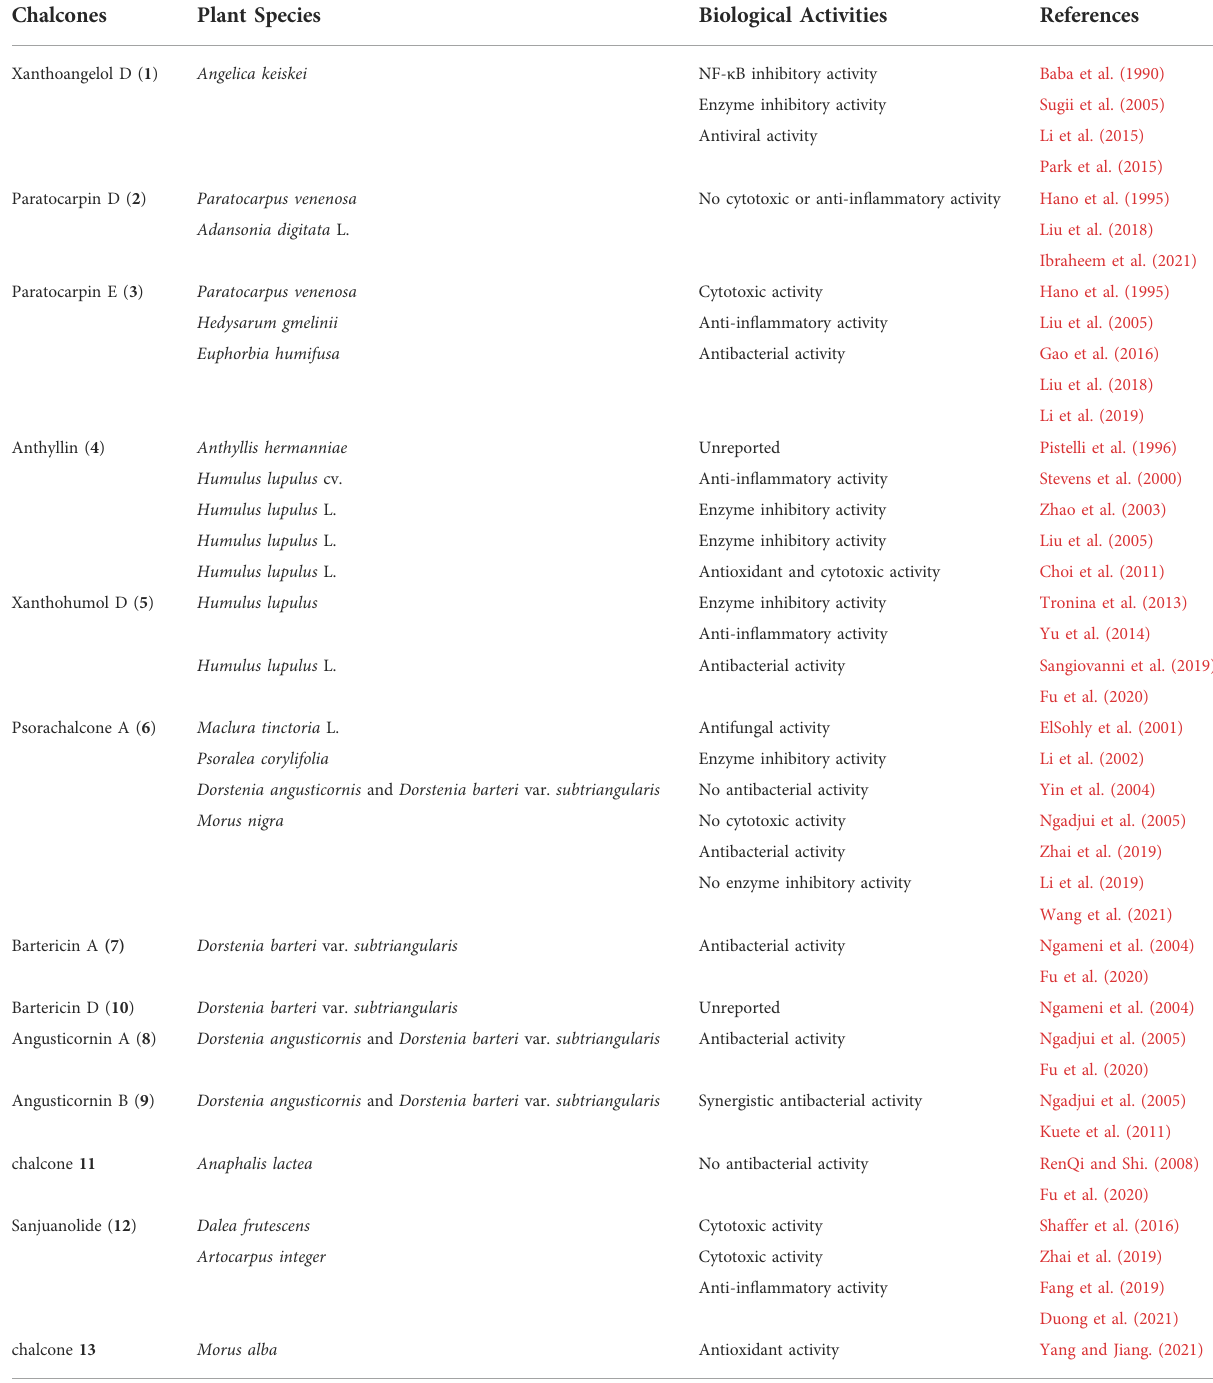
TABLE 1 Plant species and biological activities of natural chalcones bearing HMB